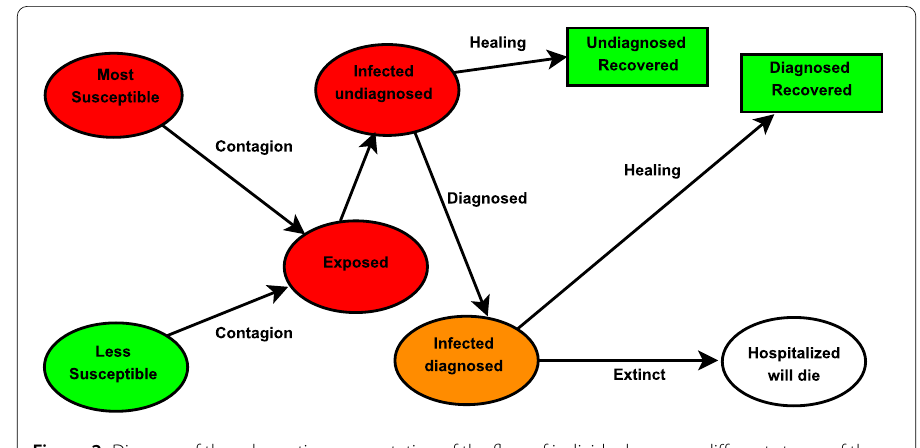
Figure 2 Diagram of the schematic representation of the flow of individuals among different stages of the infection. The mathematical model is called EIISSRRE X -model and considers two distinct susceptible compartments: S M the most susceptible individuals and S L the less susceptible individuals. Also, there are uninfected I , infected individuals, asymptomatic, and symptomatic individuals. I U stands for the infected individuals and there are asymptomatic/undiagnosed (undetected) and those who will recover R U ; R D represents those diagnosed, hospitalized individuals that will recover; E represents the group of those diagnosed hospitalized individuals who